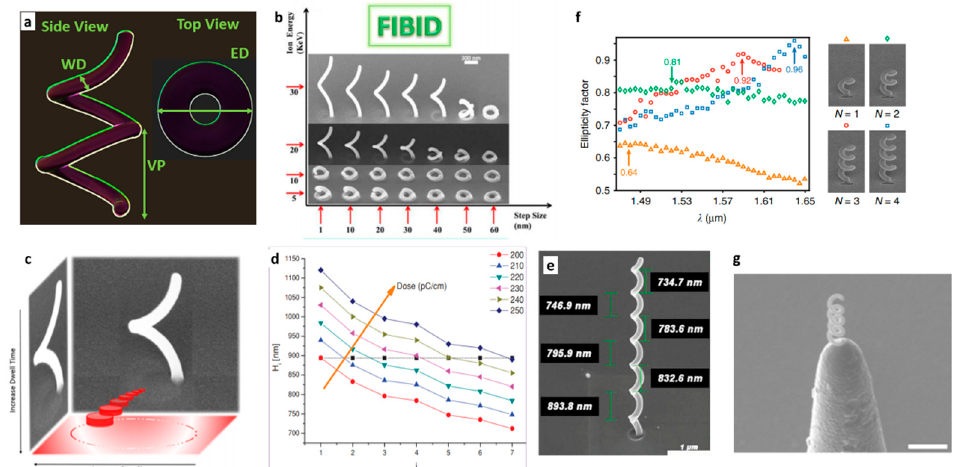
Figure 6. ( a ) Scheme of the helix geometrical parameters: Vertical Period (VP), External Diameter (ED), the wire Diameter (WD). ( b ) Scheme of the nanohelix evolution in the third dimension as a function of ion energy and step size. Reproduced with permission from [69]. ( c ) Scheme of the helix growth balancing the step size and the dwell time. Reproduced with permission from [119]. ( d ) Evolution of the vertical pitch during the multiple loop helix growth. The dashed line represents the design VP. ( e ) SEM image of a Pt-based nano-helix with seven loops realized by FIBID. The vertical pitch (VP) decreases along the z -axis from 893 nm down to 735 nm, as a result of proximity effects. d-e reproduced with permission from [54]. ( f ) Spectrum of the ellipticity factor of the single HTN emission measured for different turns: One turn (orange triangles), two turns (green diamonds), three turns (red circles), and four turns (blue squares). Reproduced with permission from [88] . ( g ) SEM image of an antenna grown at the apex of a tip used in scanning near-field microscope. The scale bar is 1 µ m. Adapted and reprinted with permission from [122] , © The Optical Society.